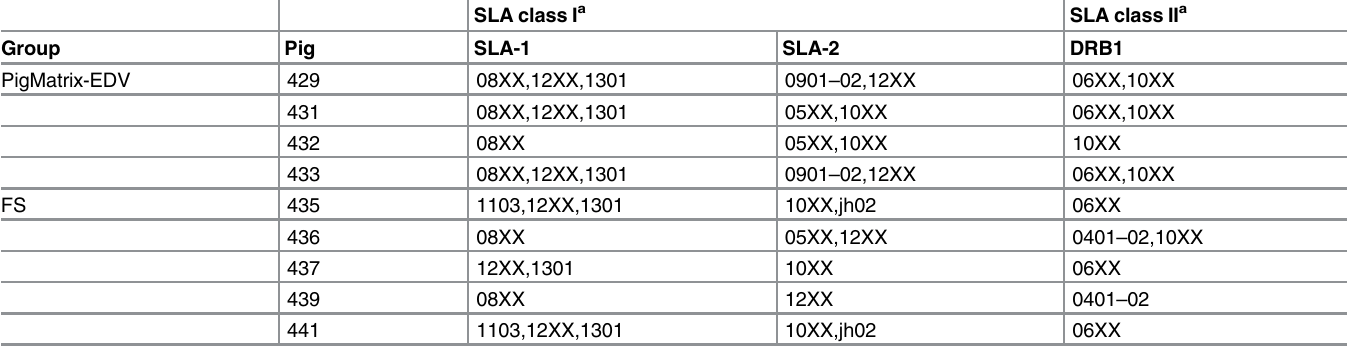
Table 1. Low resolution SLA-type alleles of pigs tested in individual peptide ELISpot assays.